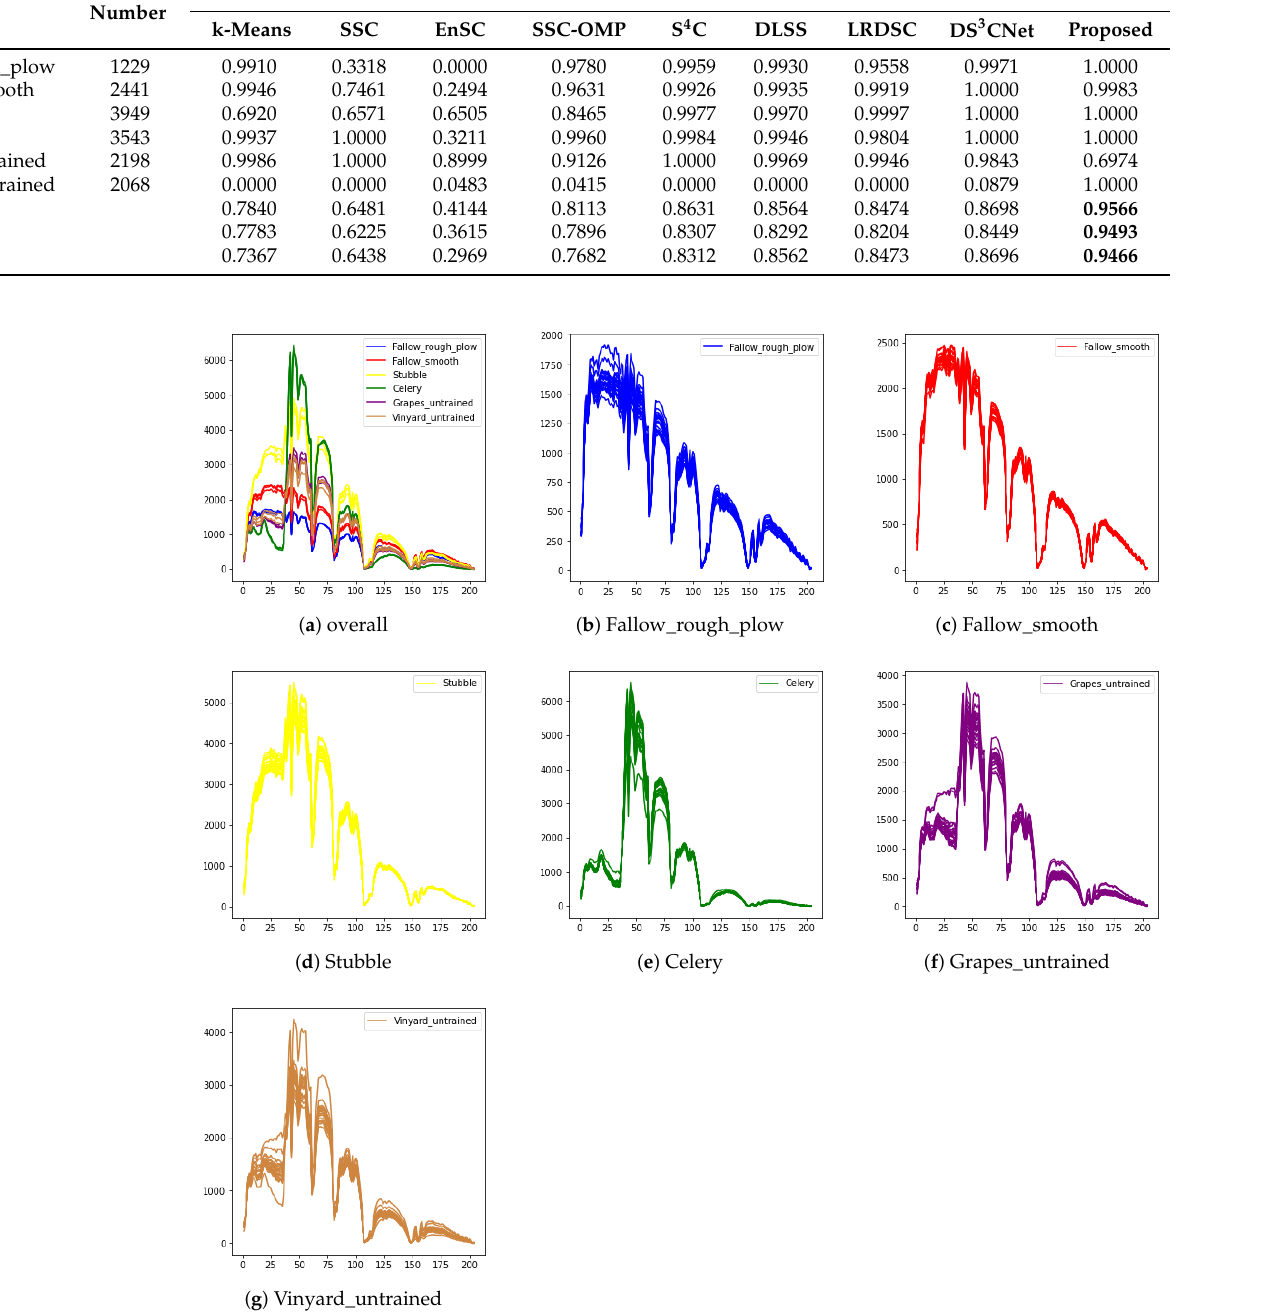
Figure 13. The spectral information of the Salinas